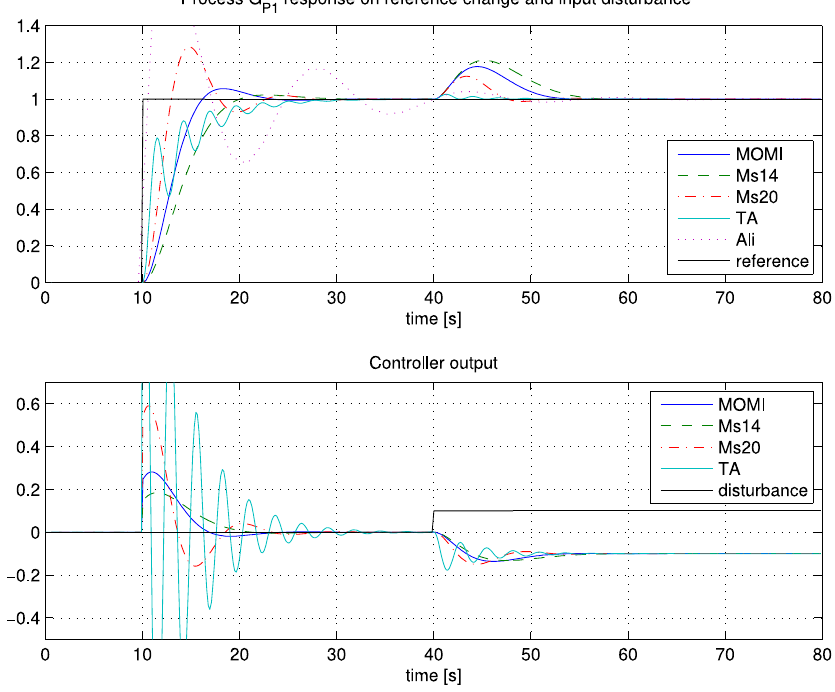
Figure 13. Closed-loop responses of G P1 process. PI controllers were tuned by the magnitude optimum multiple integration (MOMI), Ms14, Ms20, TA, and ALI methods. For clarity, the ALI response is not shown in the bottom picture. Table 4. ITSE criterion values for reference tracking.